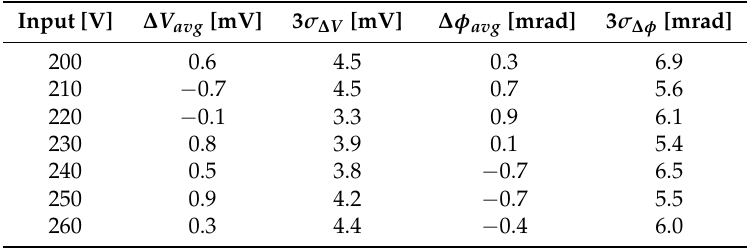
Table 1. Performance factors evaluated on a set of 10 voltage sensors.